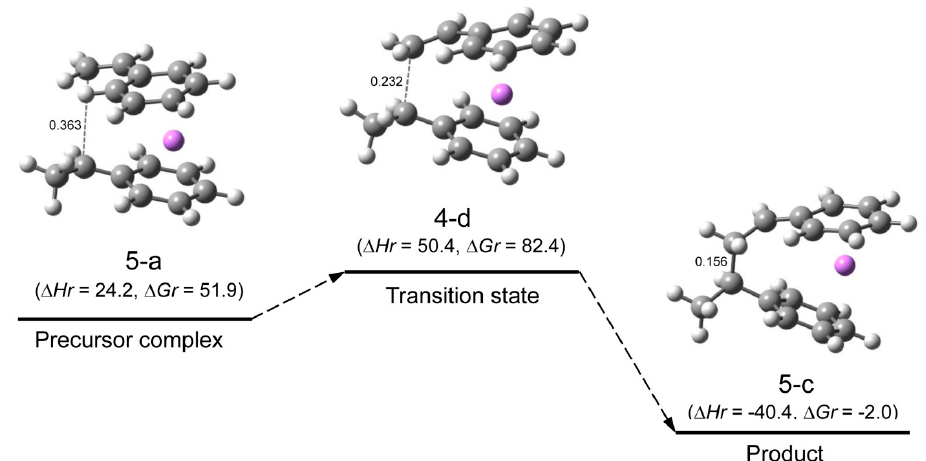
Figure 5. Reaction pathway for system(s-4-d) (St/[HStLi(2-c)]) in the gas phase. ∆ Hr and ∆ Gr , the relative enthalpy and relative free energy, are expressed in kJ·mol –1 . Numerical values in the drawings indicate the distances between the two carbon atoms participating in the reaction, in nm.